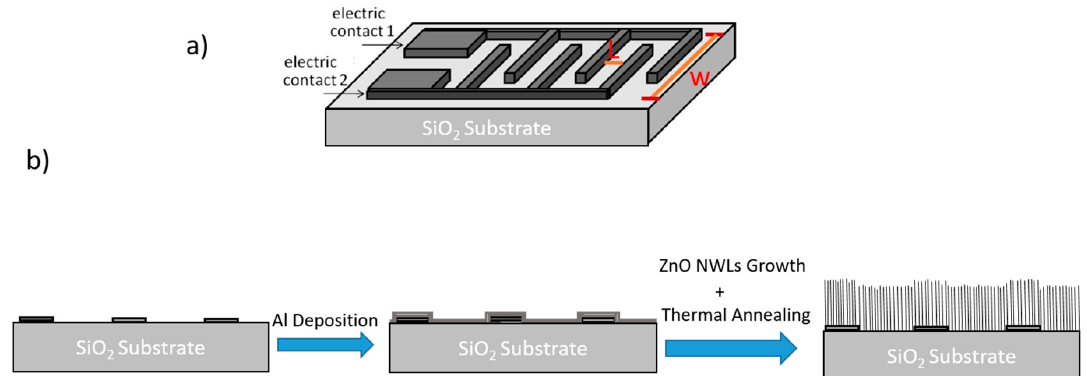
Figure 1. ( a ) Schematic (not to scale) representation of the interdigitated (ID) Au contacts and ( b ) schematization of the various steps for the synthesis of Zinc Oxide (ZnO) nanowalls (lateral-view). The I-V characteristics of this system was obtained by using a Keithley 4200-SCS system by positioning two conductive tips on the pads of the ID contacts.